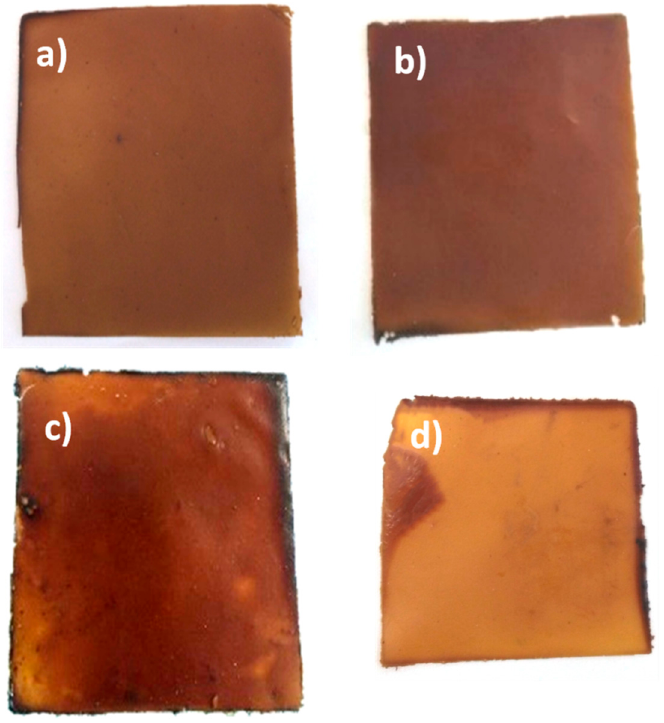
Figure 1. Photographs of each resulted bioplastic films: ( a ) from crude rapeseed cake; ( b ) from defatted cake; ( c ) from deproteinized cake; ( d ) from defatted and deproteinized rapeseed cake.